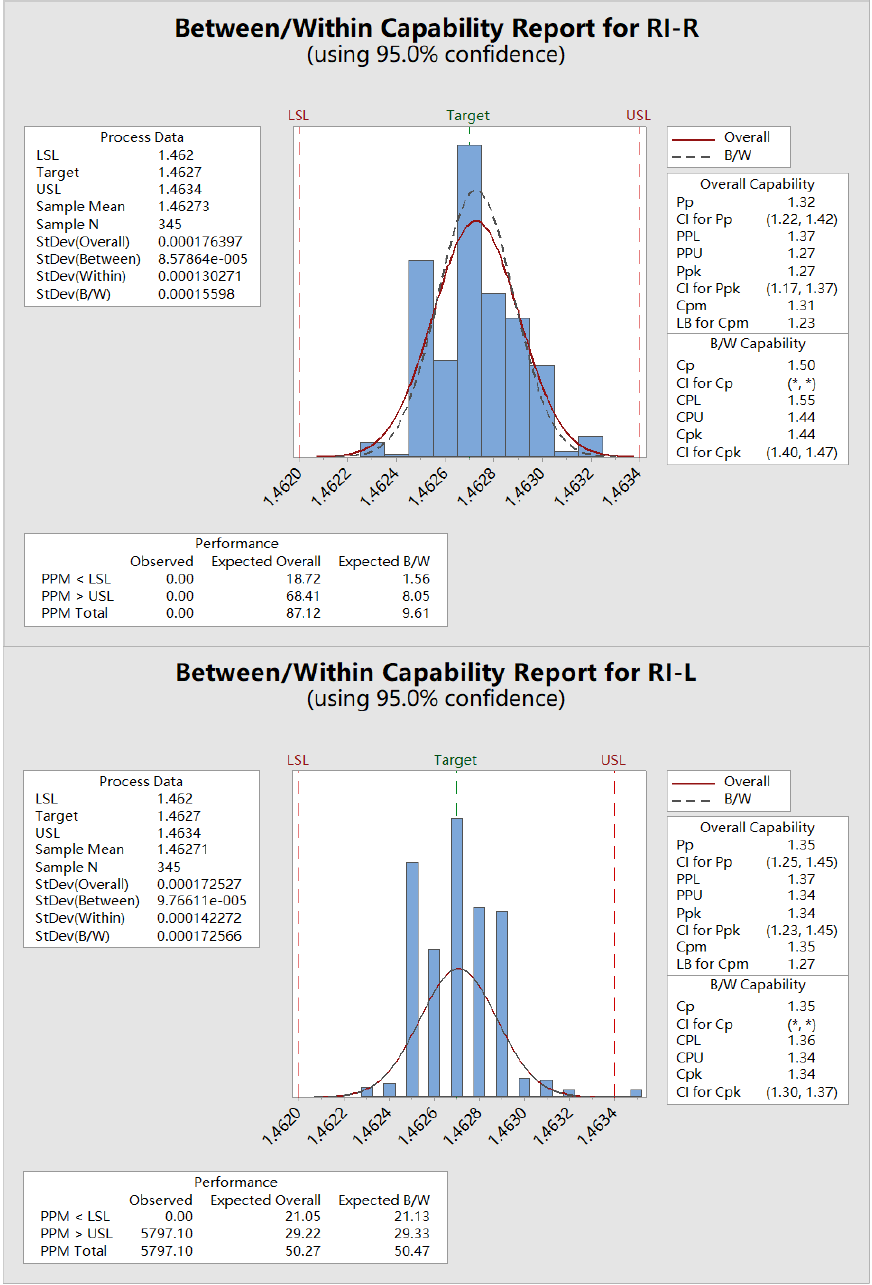
Figure 1. Refractive index (RI) maps and histograms for the 345 wafers with their specification limits and target for RI-B, RI-C, RI-T, RI-R and RI-L. LSL = 1.4620, USL = 1.4634 and the target = 1.4627.